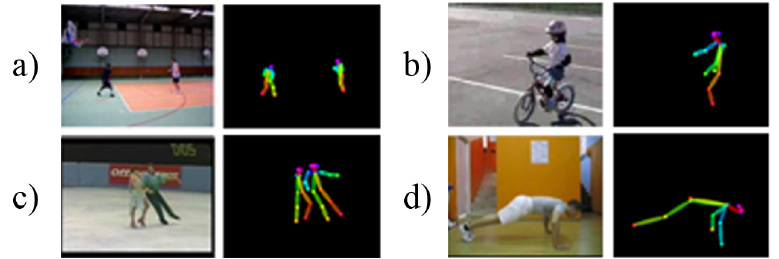
Figure 5. Example of an RGB image with corresponding keypoints inputs. ( a ) “Basketball”. ( b ) “Biking”. ( c ) “IceDancing”. ( d )